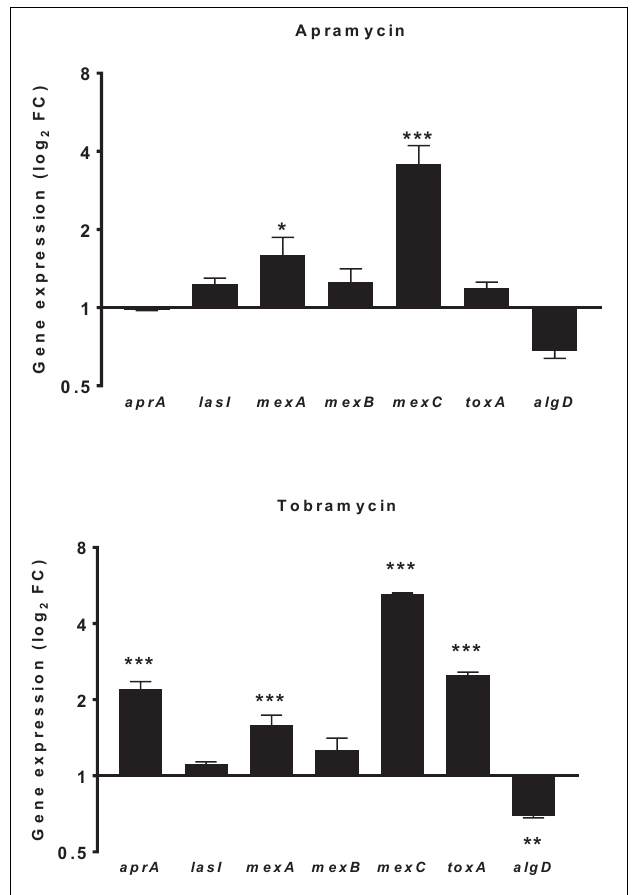
FIGURE 6 | Effect of drug exposure on the expression of P. aeruginosa virulence genes. The effect of 20 h-exposure of apramycin and tobramycin at 0.25xMIC on the expression of aprA (alkaline protease), lasI (quorum sensing mediator), mexA-B-C (multidrug efflux pumps), toxA (exotoxin A), and algD (alginate synthesis) by P. aeruginosa PaPh32 was measured using the real-time RT-qPCR technique. Control samples (CTRL) were not exposed to drug. The relative expression of each gene was normalized to that of the housekeeping gene ( proC ). Results are presented as fold change (FC: 2 − (cid:49)(cid:49) ct , mean ± SD) on a log 2 scale. Statistical significance at ordinary one-way ANOVA followed by Tukey’s multiple comparisons post-test: * p < 0.05, ** p < 0.01, and *** p < 0.001 vs. CTRL.